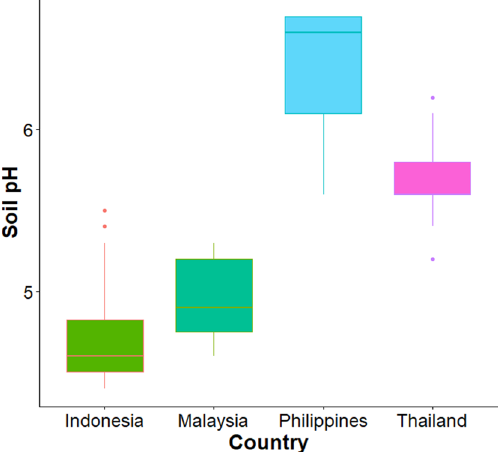
Figure 2. The soil pH level (at the 0-5 cm depth) of the soil samples from the four countries were significantly different.